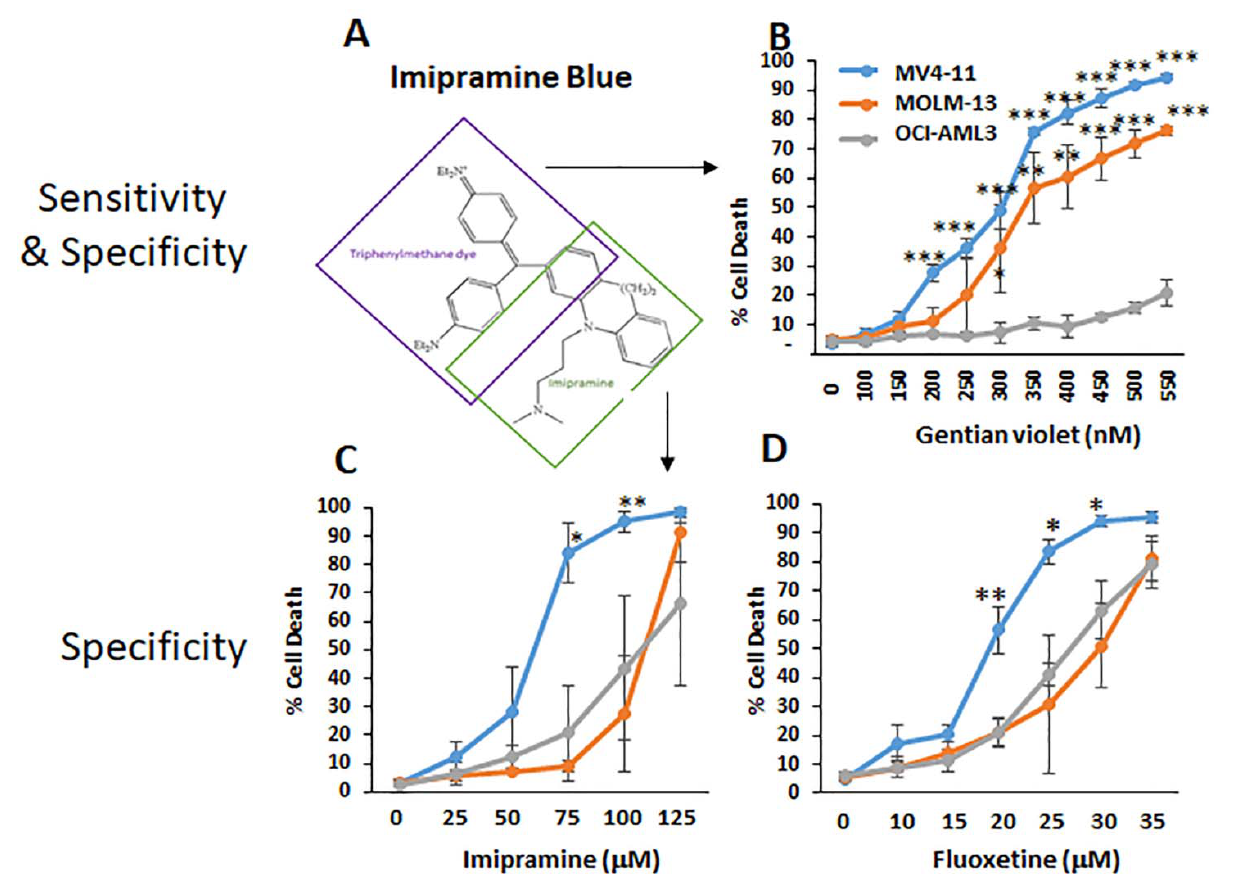
Figure 4. Structure–function analysis of imipramine blue reveals two moieties with AML targeting activity. ( A ) Imipramine blue is the chimeric compound generated through fusion of a triphenylmethane dye with imipramine. To determine the functional roles of the parental constituents, cytotoxicity assays were performed. ( B ) The gentian violet moiety was tested for both sensitivity and specificity for Flt3-ITD + AML cells ( n = 3). ( C ) In comparison, the imipramine moiety was also tested in MV4-11 cells ( n = 3). ( D ) As with imipramine, another anti-depressant drug fluoxetine was tested to determine whether it would have a similar cytotoxicity profile. Note that the legend and colors for the lines are the same for panels B-D but is only included in panel D because of space constraints. p values for panels B-D are calculated at individual drug concentrations relative to OCI-AML3 cells at the same concentration. * p < 0.05; ** p < 0.01; *** p < 0.001.